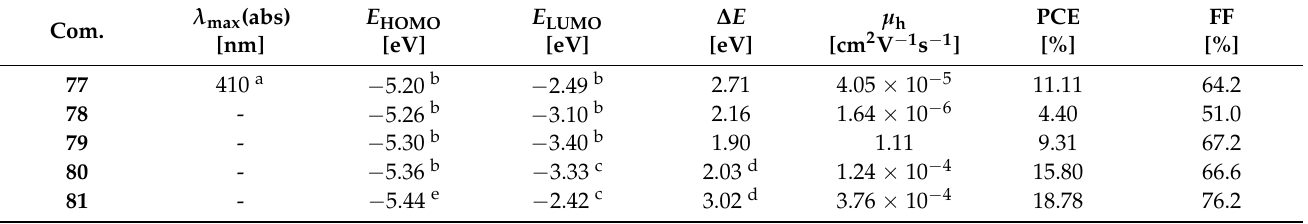
Table 7. The optoelectronic properties overview of derivatives 77 – 81 , applied in PSCs as HTM.